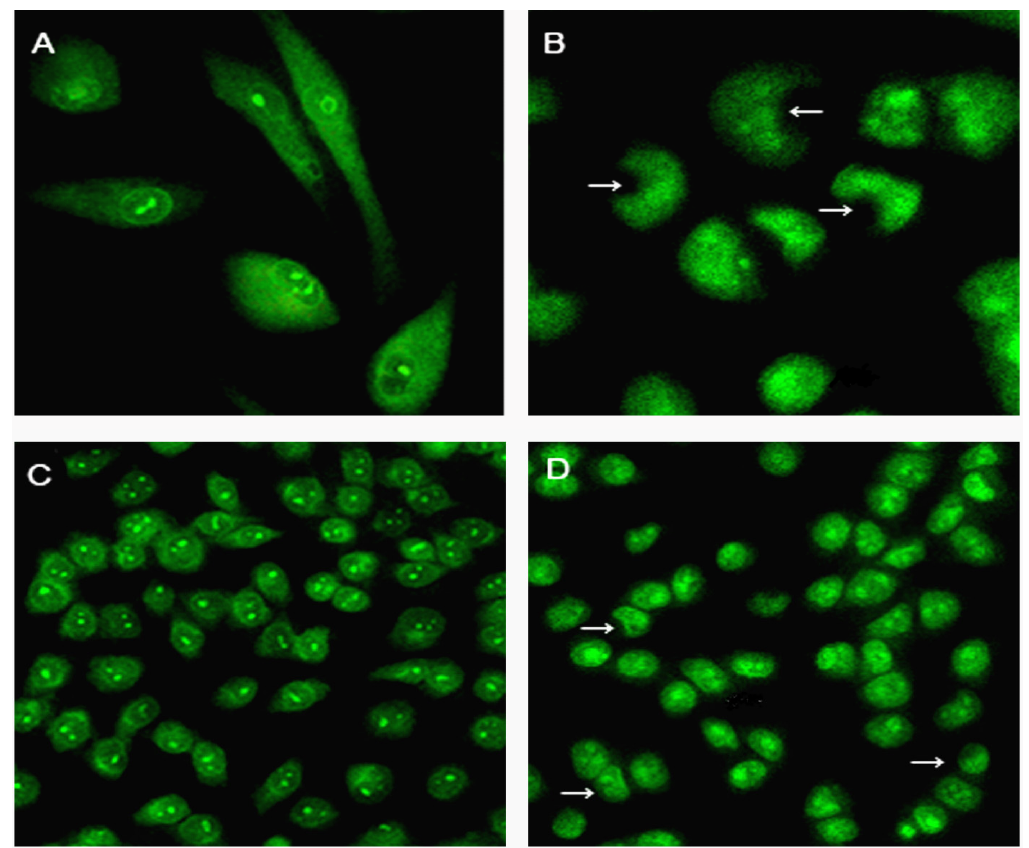
Figure 5. Morphological changes in MCF-7 cells treated with CPT6 for 48 h examined